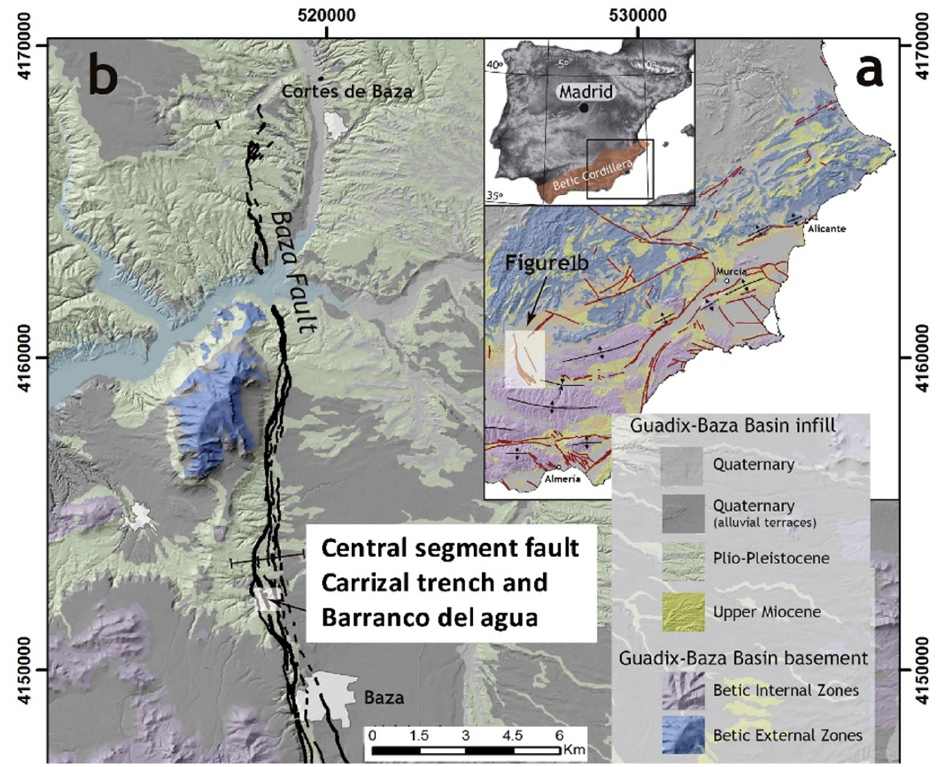
Figure 1. ( a ) Geological situation of the Betic Cordillera. ( b ) Geological map of the Baza Fault. Modified from Torabi et al. [3].